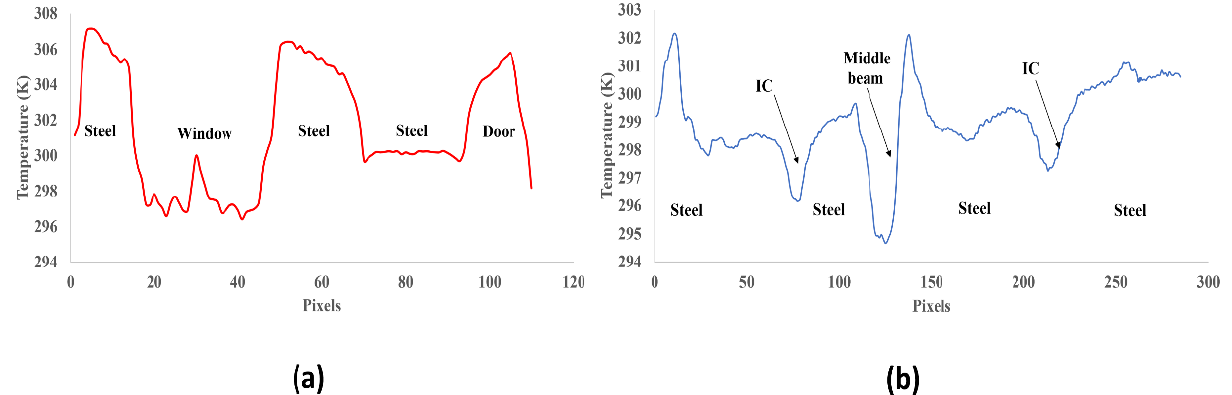
Figure 15. Temperature distribution following ( a ) along Line 1 and ( b ) along Line 2.